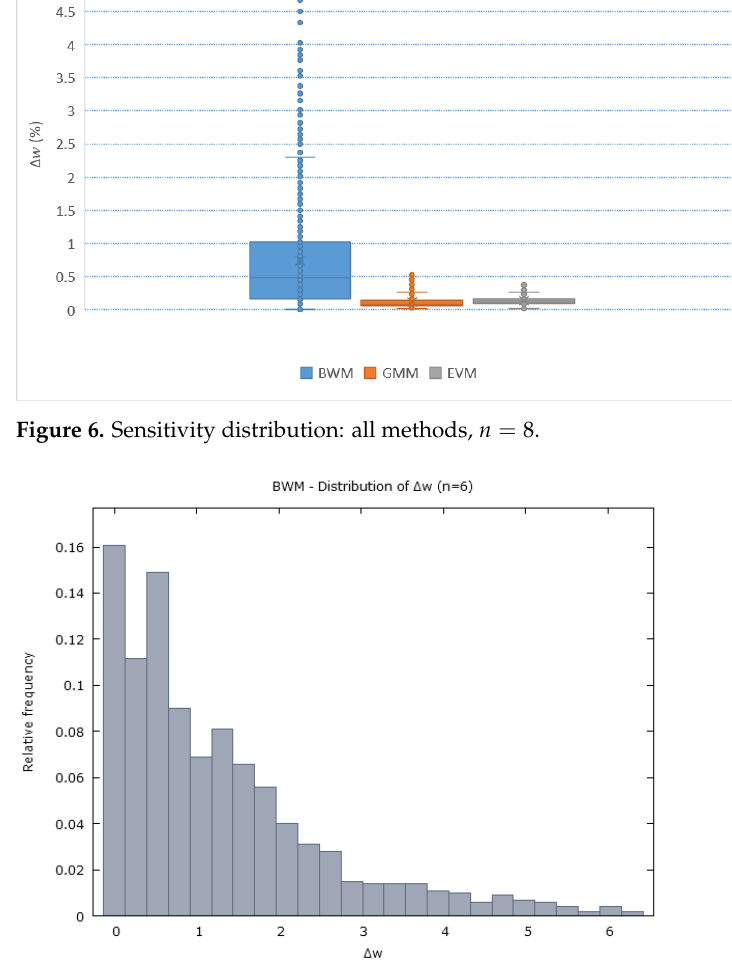
Figure 7. Sensitivity of the BWM: frequency distribution, n =